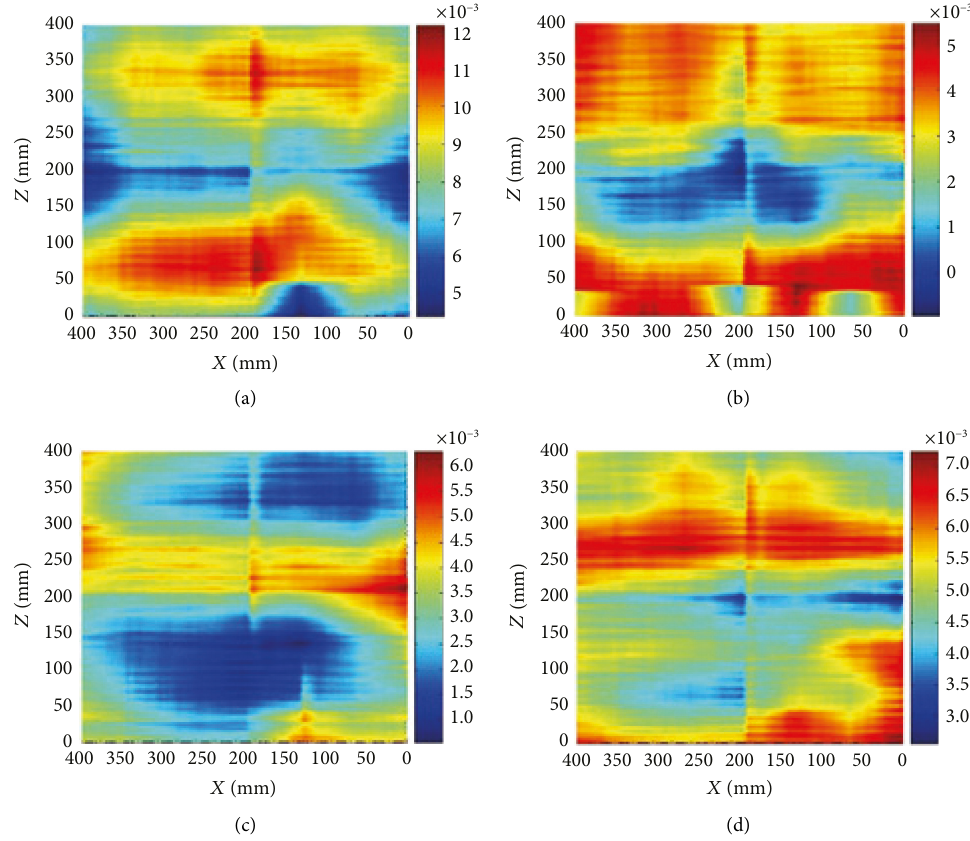
Figure 6: PV of the original and compensated aspherical surface [25]. (a) Initial processing (PV � 7.77 μ m; RMS � 1.35 μ m). (b) First compensation processing (PV � 6.39 μ m; RMS � 1.24 μ m). (c) Second compensation processing (PV � 5.71 μ m; RMS � 1.02 μ m). (d) Third compensation processing (PV � 4.67 μ m; RMS � 0.72 μ